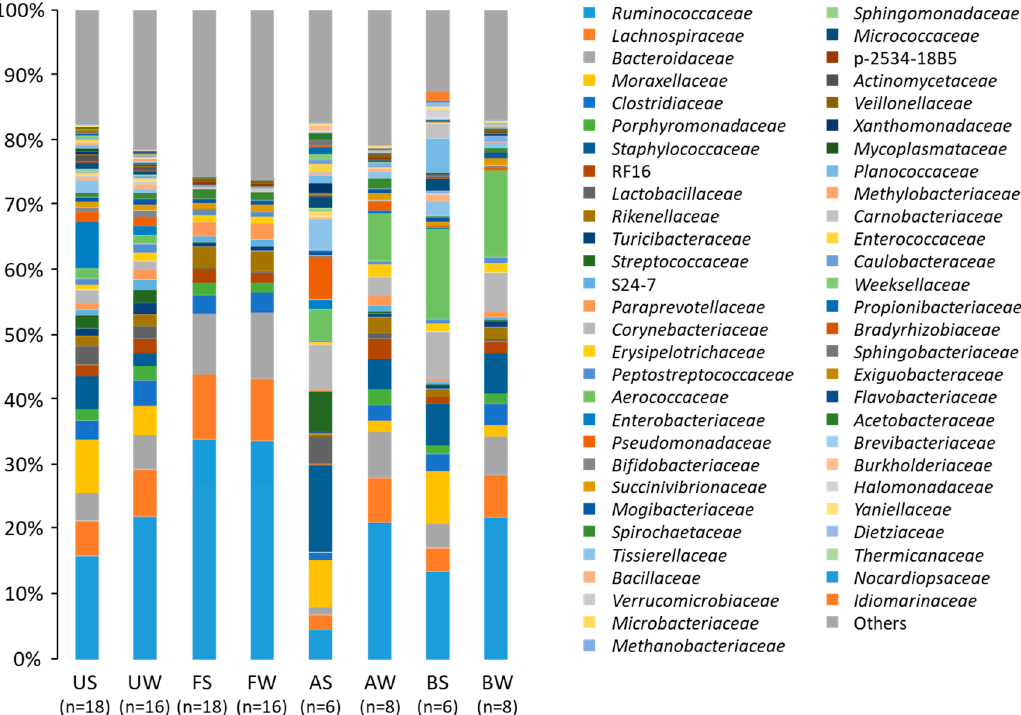
Figure 1. Uterine, fecal, bedding, and airborne dust microbiota in the dairy farm examined during two seasons. AS, AW, BS, BW, FS, FW, US, and UW indicate airborne dust during summer, airborne dust during winter, bedding during summer, bedding during winter, feces during summer, feces during winter, uterine mucus during summer, and uterine mucus during winter, respectively.